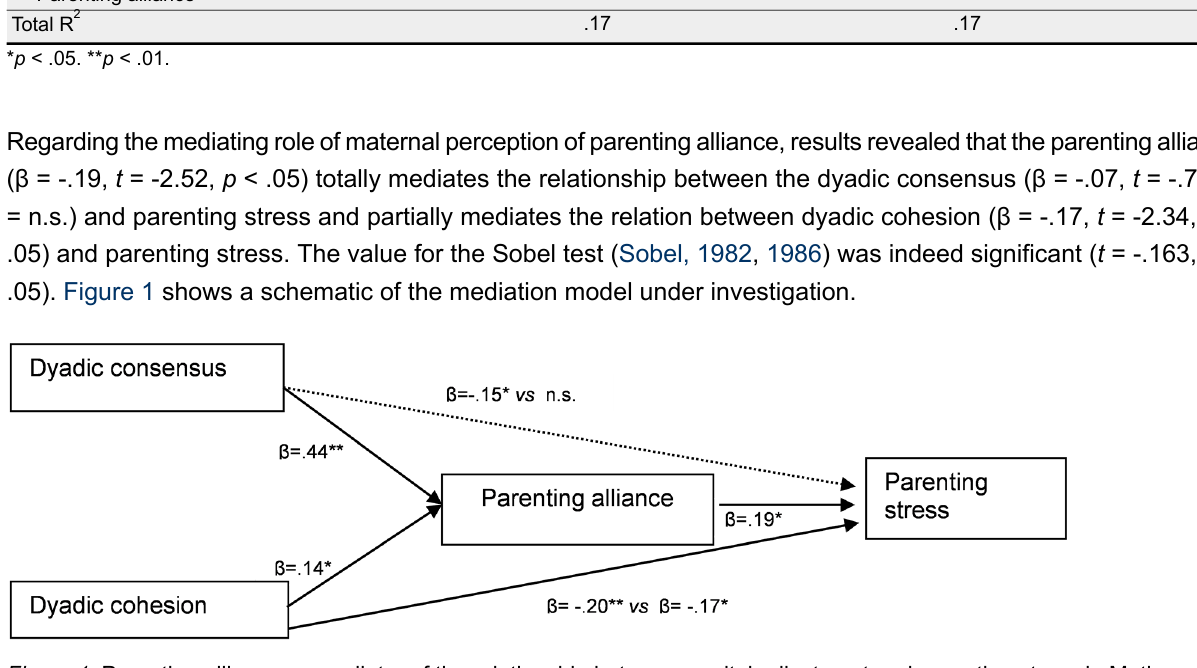
Figure 1. Parenting alliance as mediator of the relationship between marital adjustment and parenting stress in Mothers (N =